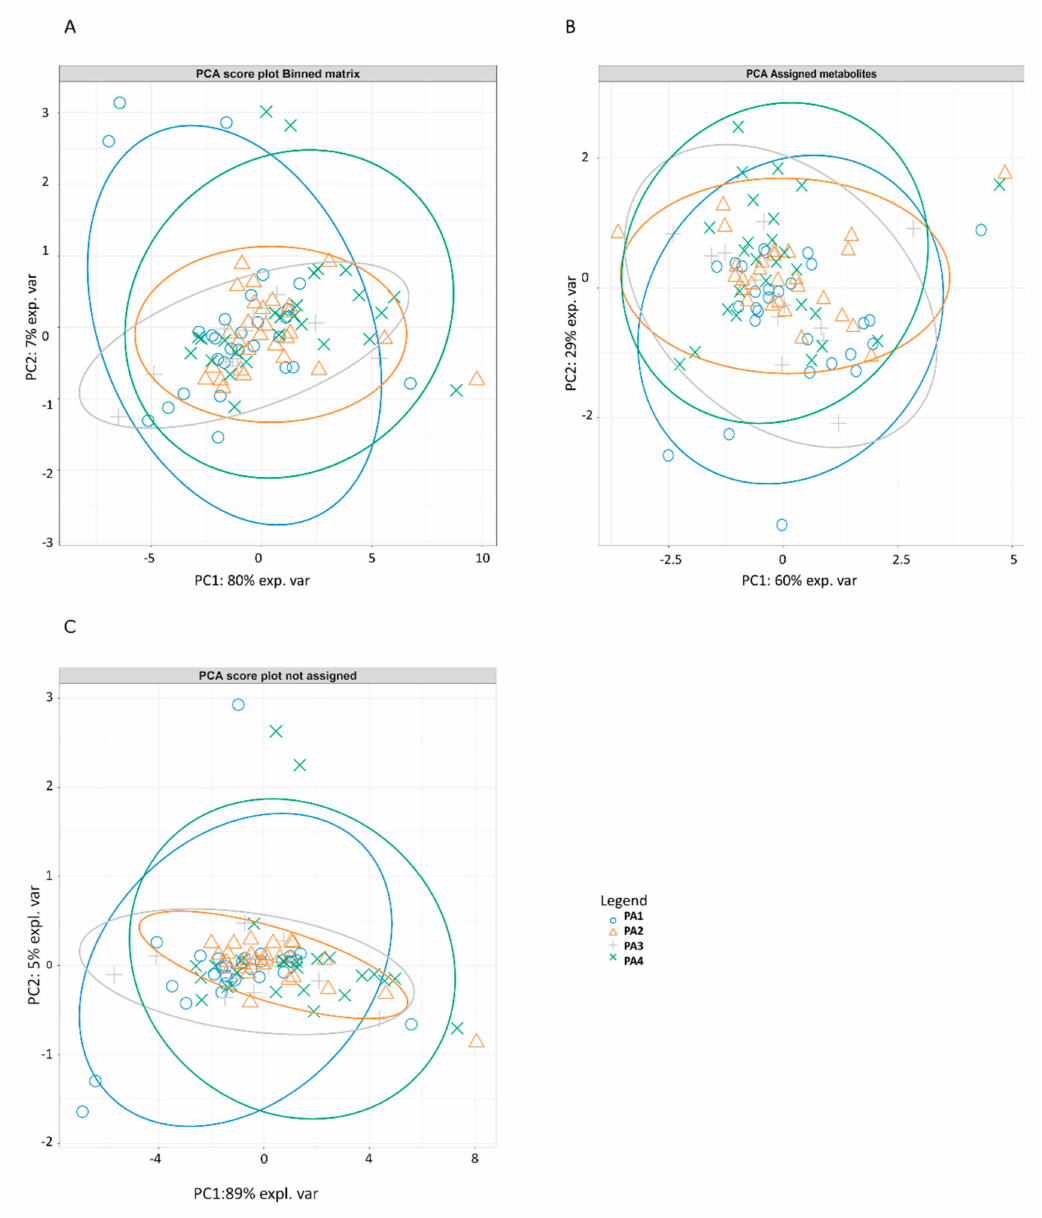
Figure 1. Individual score plot of principal component analysis (PCA) on the total binned spectra matrix ( A ), the assigned compounds ( B ), and the un-assigned binned spectra matrix ( C ). PCA score plot showing principal components 1 and 2 (PC1 and PC2). Shape refers to the respective sow’s